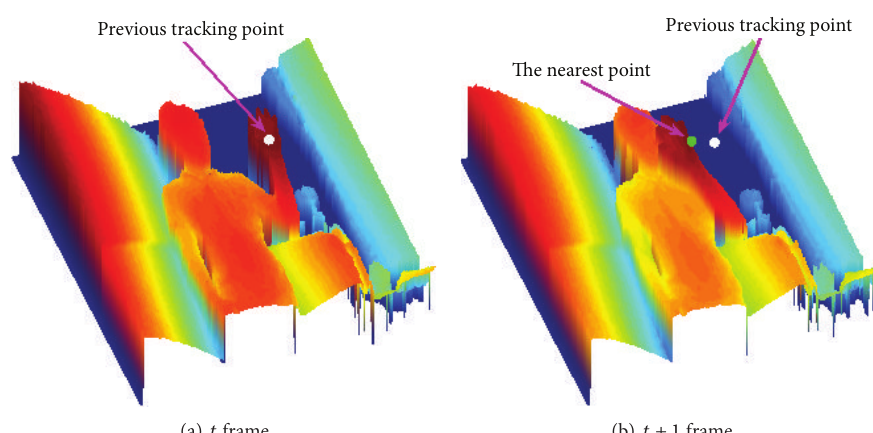
Figure 7: Result of merge process.